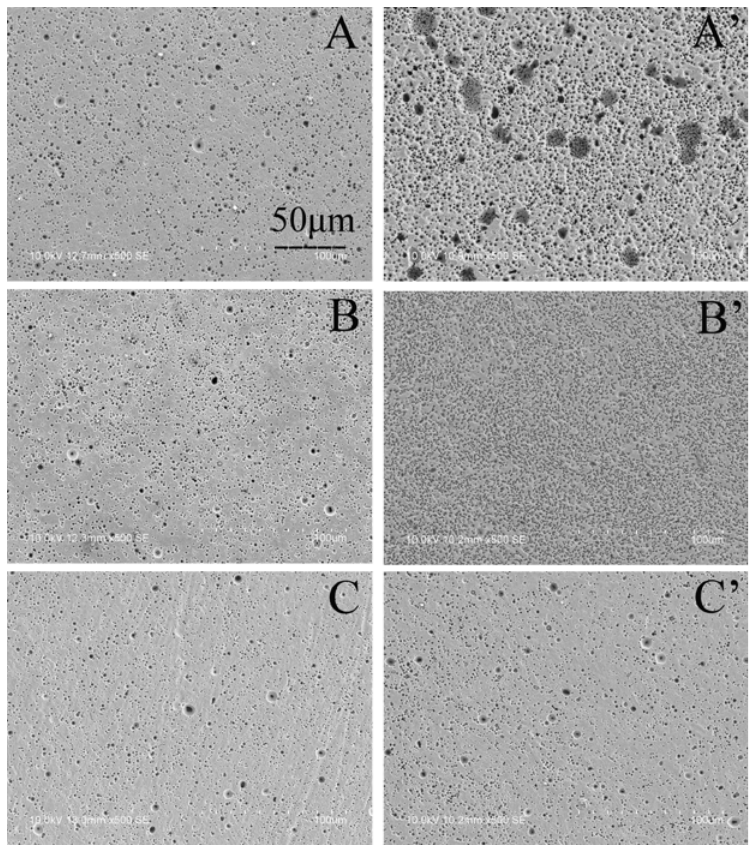
Figure 4. The surface morphologies of electrodes after 200 s polarization with injecting different solutions ( A ) no injection; ( A’ ) 0.5 M H 2 SO 4 + 0.02 M NaCl; ( B ) 0.5 M H 2 SO 4 + 0.02 M NaNO 3 ; ( B’ ) 0.5 M H 2 SO 4 + 0.02 M NaCl + 0.02 M NaNO 3 ; ( C ) 0.5 M H 2 SO 4 + 0.2 M NaNO 3 ; ( C’ ) 0.5 M H 2 SO 4 + 0.02 M NaCl + 0.2 M NaNO 3 .